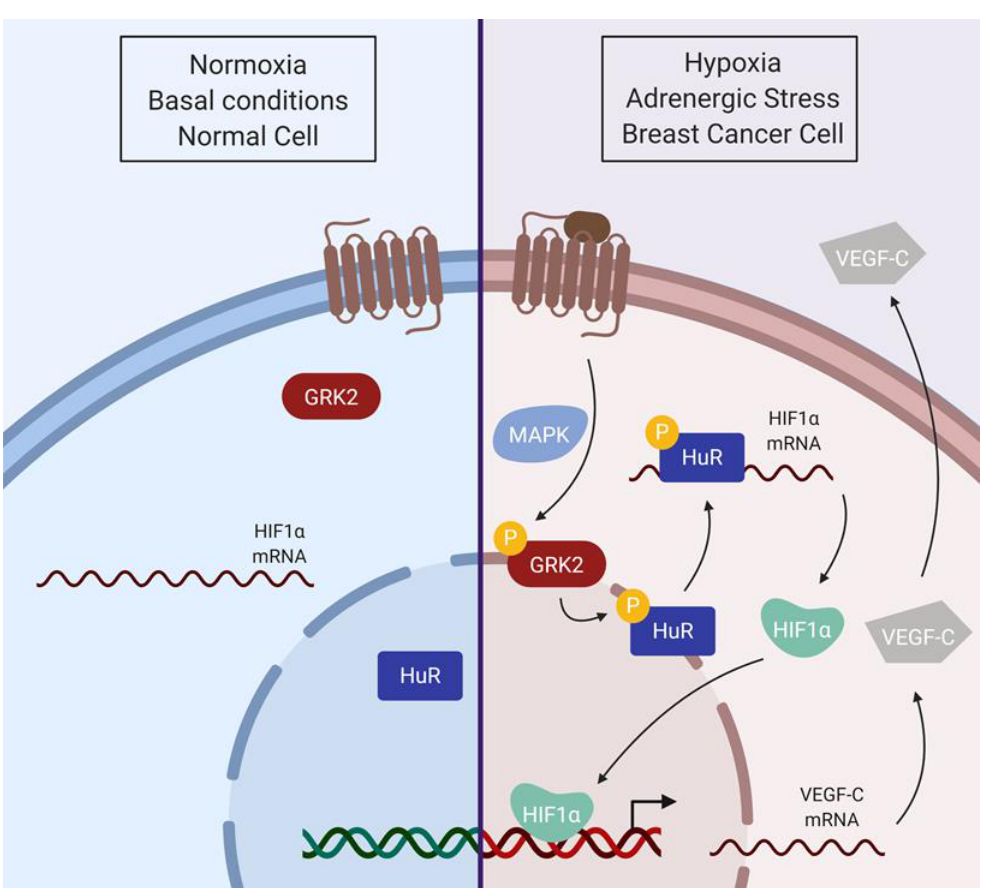
Figure 7. Model for the GRK2-dependent activation of the HuR/HIF1α axis. In basal conditions, the main HuR protein pool is located in the nucleus. Hypoxia or adrenergic signaling facilitates GRK2 phosphorylation at Ser670, enabling HuR phosphorylation by GRK2, thus increasing HuR nuclear export. Cytosolic HuR protein binds to and stabilizes HIF1-α mRNA, increasing protein translation and HIF1-α function as a transcription factor. As a consequence, transcription and protein secretion of the VEGF-C angiogenic factor would be enhanced (scheme created with BioRender). Ser670 phosphorylation is an emerging regulatory switcher in GRK2 substrate specificity and